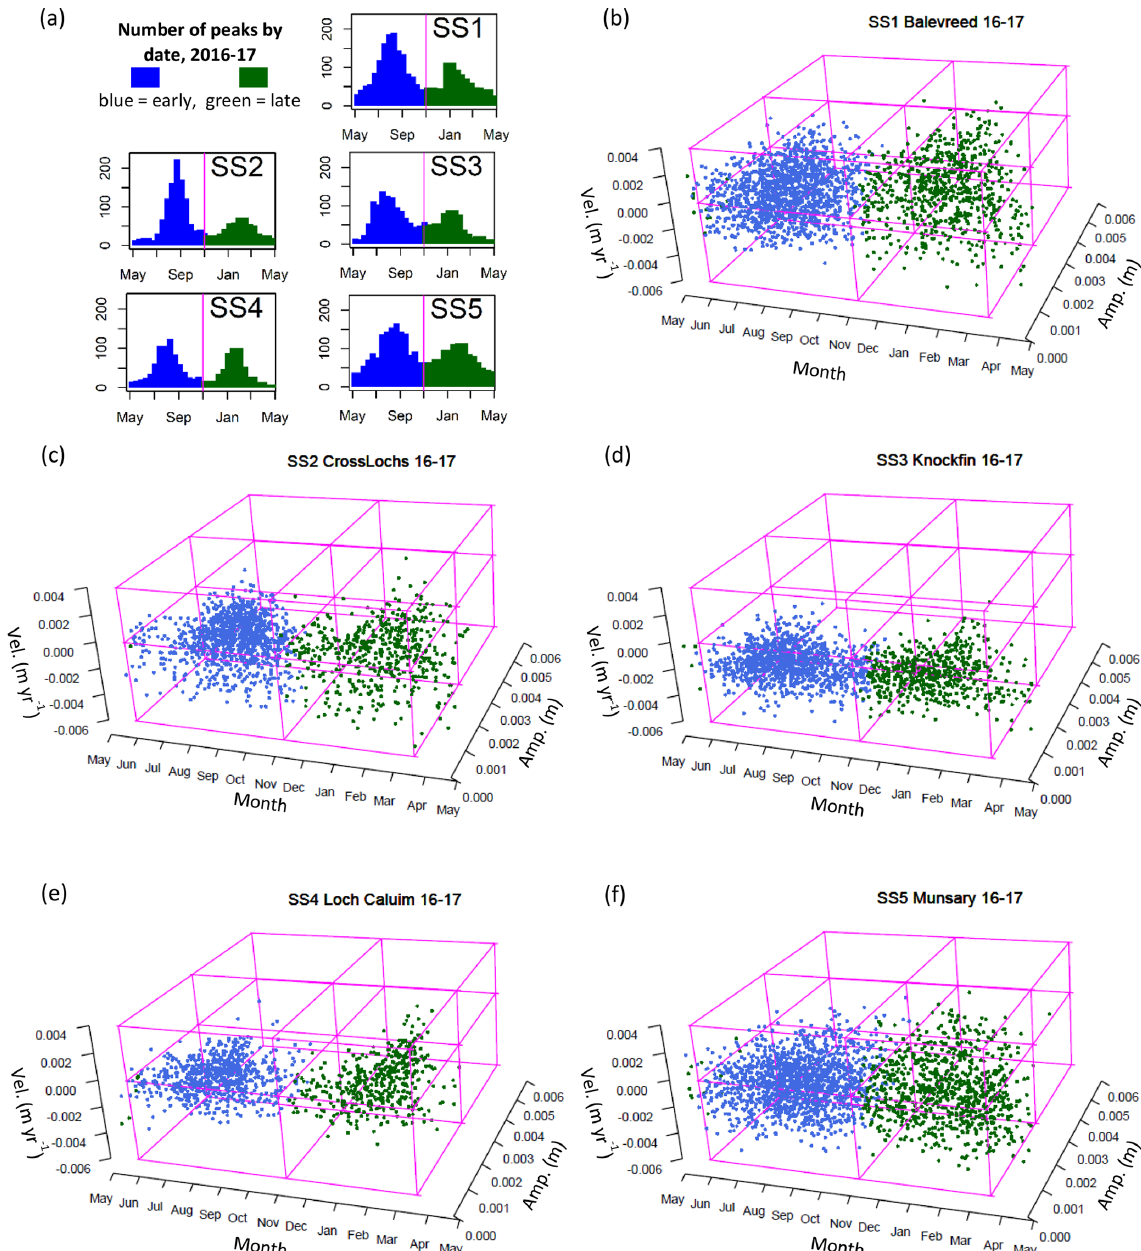
Figure 3. Characteristics of the motion metrics by sub-site (SS) calculated from MSSA reconstructions of the InSAR-detected annual motion between 10 May 2016 to 9 May 2017. (a) Frequency of peak timing throughout the motion year, where May is the period of least surface motion activity, with a binomial distribution split at 10 November into an early (blue) and late (green) cluster. (b–f) Three-axis plots of the surface motion metrics: (b) SS1 Balavreed, (c) SS2 Cross Lochs, (d) SS3 Knockfin Heights, (e) SS4 Loch Caluim, (f) SS5 Munsary. Axis: x , peak time (Month); y , amplitude (Amp.: m), z , multi-annual average velocity (Vel.: myr − 1 ). For multi-annual average velocity, greater positive is peatland growth and greater negative is peatland subsidence. Magenta box is for visual reference. Each sub-site demonstrates a specific range in peatland condition according to the plot space it